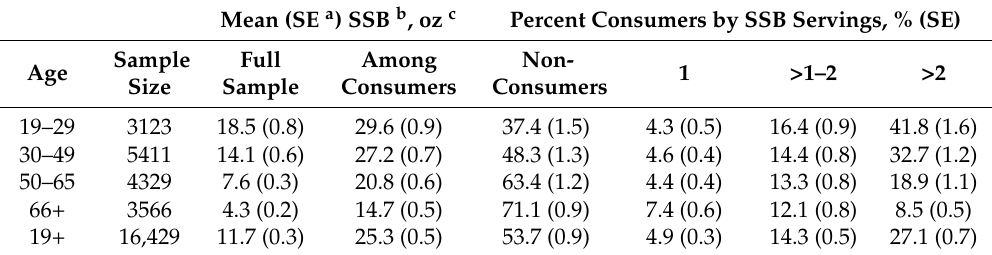
Table 2. Distribution of SSB consumption and percent consuming among adults (aged 19+), NHANES